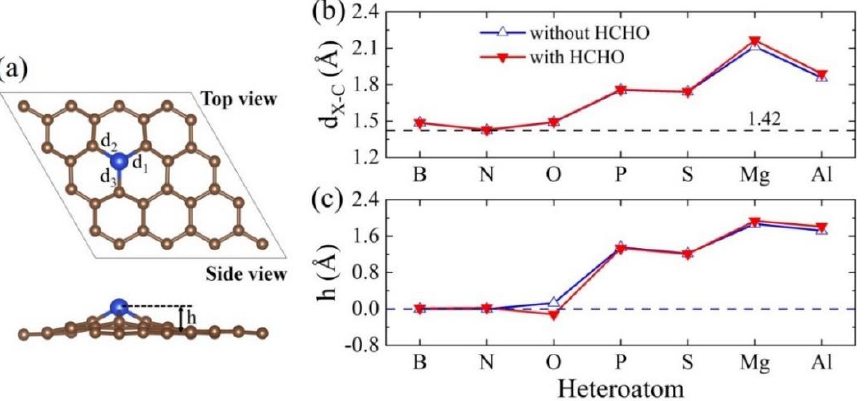
Figure 1. ( a ) Typical atomic geometry of heteroatom-doped graphene sheet. The blue ball indicates the heteroatom and the brown balls are carbon atoms, ( b ) average bond lengths (d X–C = (d 1 + d 2 + d 3 )/3) between the heteroatom and adjacent carbon atoms, and ( c ) heights of the dopant protrusion from the graphene with or without HCHO adsorption.